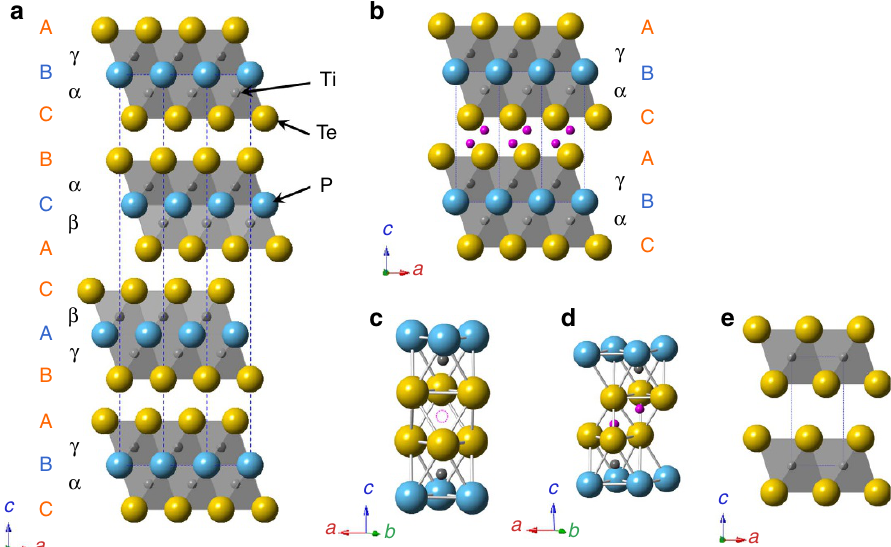
Figure 1 | Crystal structures of T 2 PTe 2 ( T ¼ Ti and Zr) and their intercalated derivative. ( a ) T 2 PTe 2 (3R-Ta 2 CS 2 type with space group R -3 m ) and ( b ) metal-intercalated M x T 2 PTe 2 (1T-Ta 2 CS 2 type with space group P -3 m 1), where black, blue, yellow and purple spheres, respectively denote Ti/Zr, P, Te and M atoms. A, B, C are used to represent anion (Te, P) stacking arrangement, while a , b , g represent the Ti/Zr stacking sequence. The unit cells are shown by the dotted lines. ( c ) Coordination environment around an octahedral void (dotted circle) in the 3R structure. ( d ) Coordination environment around a tetrahedral void in the 1Tstructure. In M x T 2 PTe 2 , the voids are partially occupied by M (for example, B 20% for Zn). ( e ) Crystal structure of TiTe 2 and MX 2 compounds in general ( M ¼ Ti, Zr, Ta and so on; X ¼ S, Se).